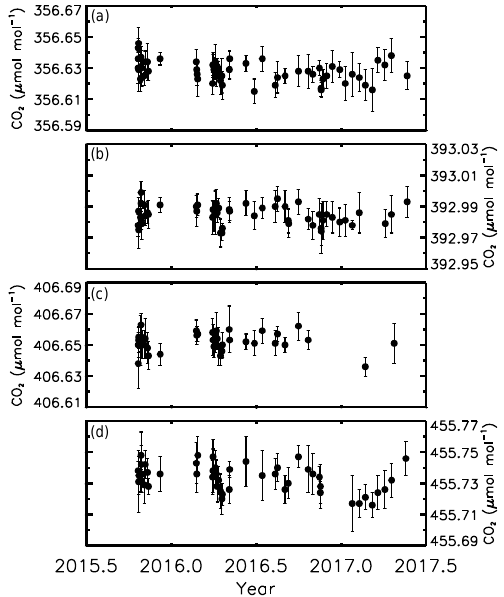
Figure 2. Total CO 2 calibration results for four target tanks measured on the laser spectroscopic CO 2 calibration system over approximately 1 year. Error bars are the standard deviation of eight measurements per calibration episode. The results span multiple gas handling system modifications. Values since April 2016 are on the final design. Average and standard deviations of the four target tanks results are (a) CC71624 356.628 ± 0.007µmolmol − 1